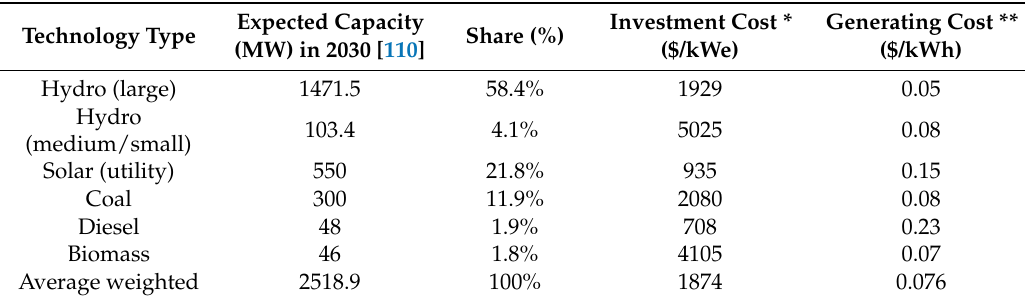
Table A4. Expected generation mix, investment costs and generating costs for the expected centralized grid technologies in Malawi in